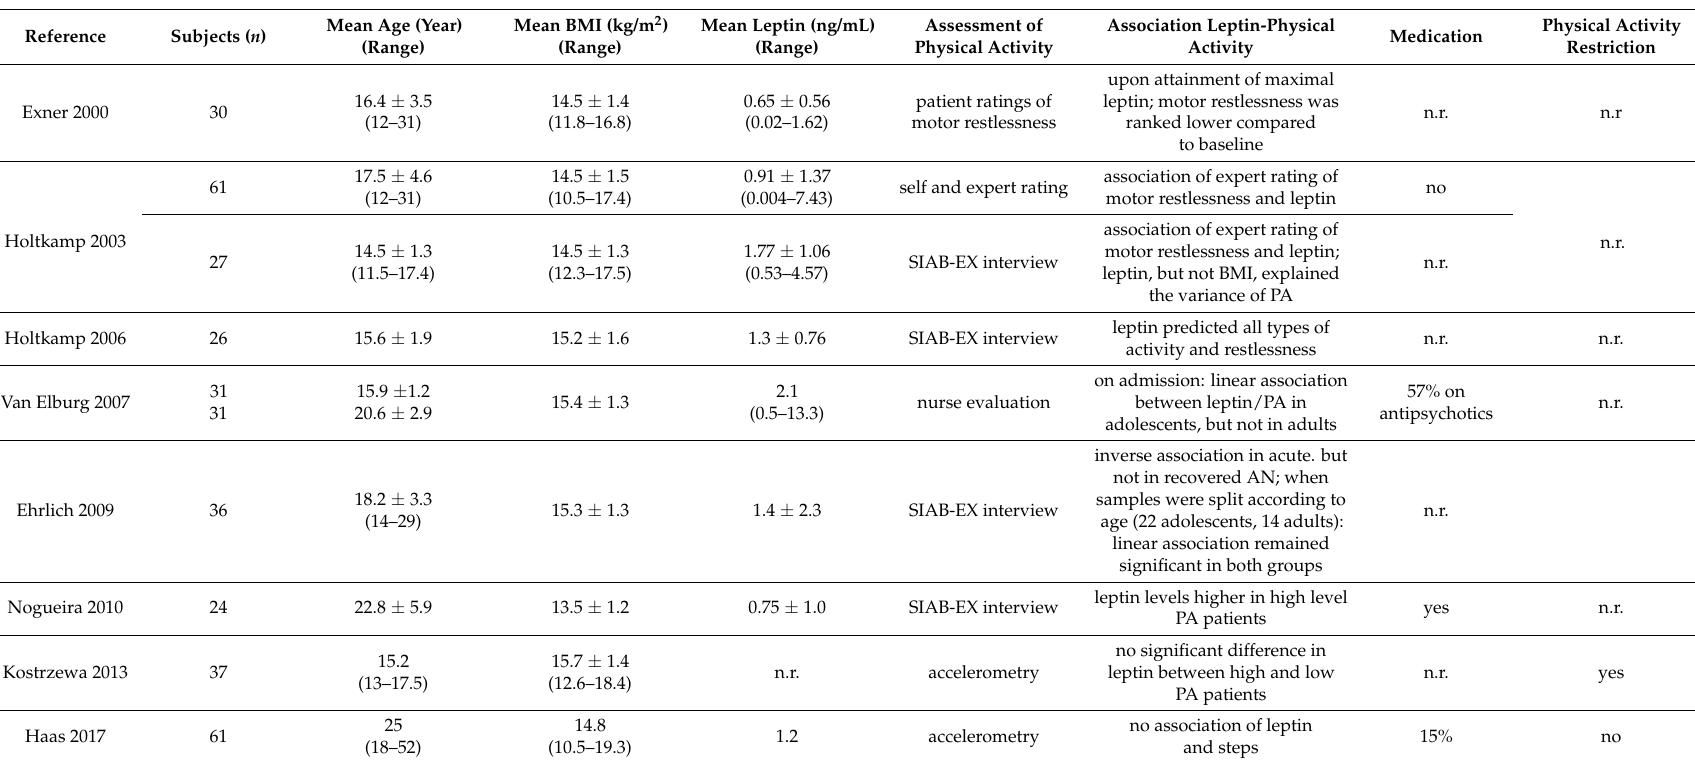
Table 2. Previous studies reporting on the association of leptin and physical activity in patients with